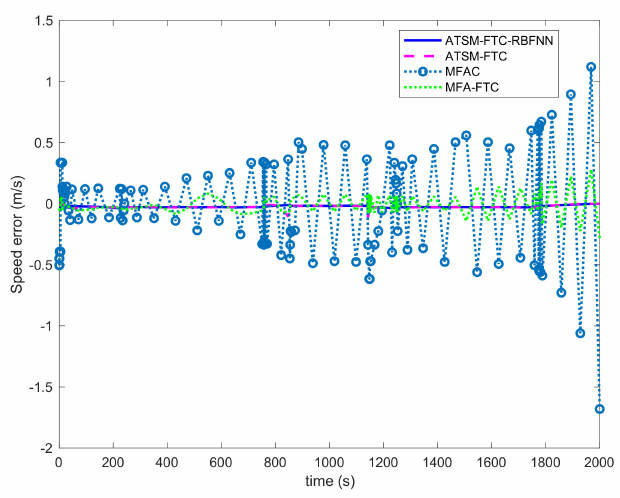
Figure 15. Speed error comparison.